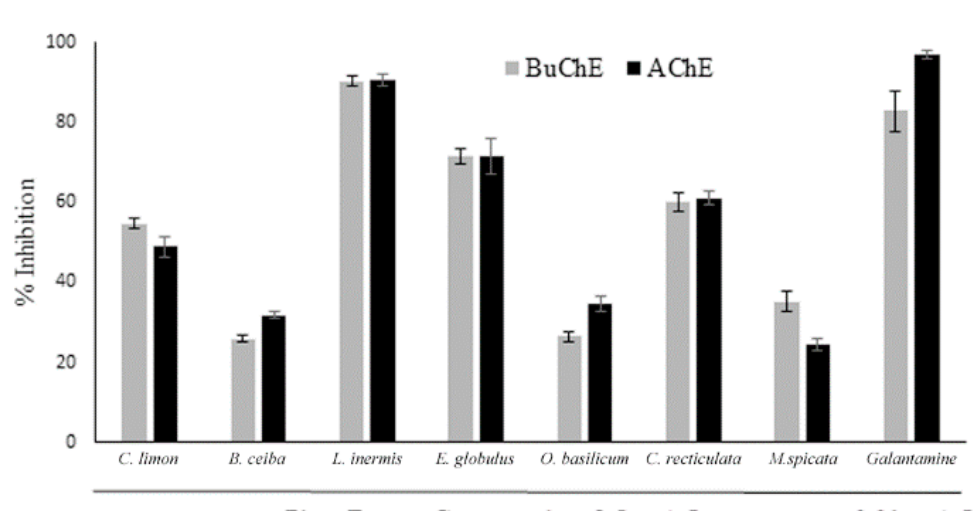
Figure 3. Comparison of BuChE and AChE inhibitory activity for plant extracts. The ability of plant extracts at 2.5 mg / mL to inhibit BuChE and AChE was compared with that for galantamine at 0.01 mg / mL. Results are expressed as means ± SEM, for an n -number of 4.